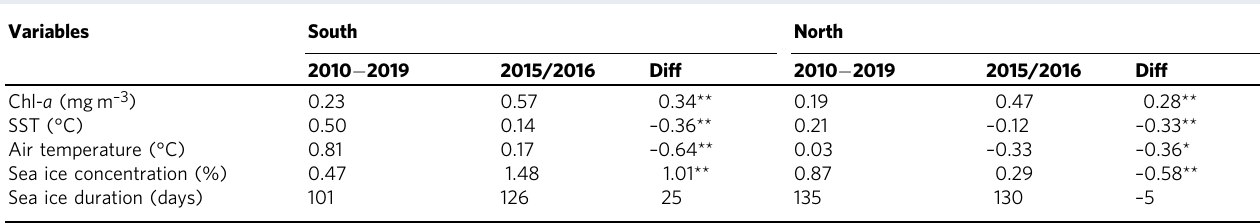
Table 1 Biological production and ocean/atmosphere parameters by measurements of remote sensing and local meteorological stations during spring/summer in the NAP subregions.